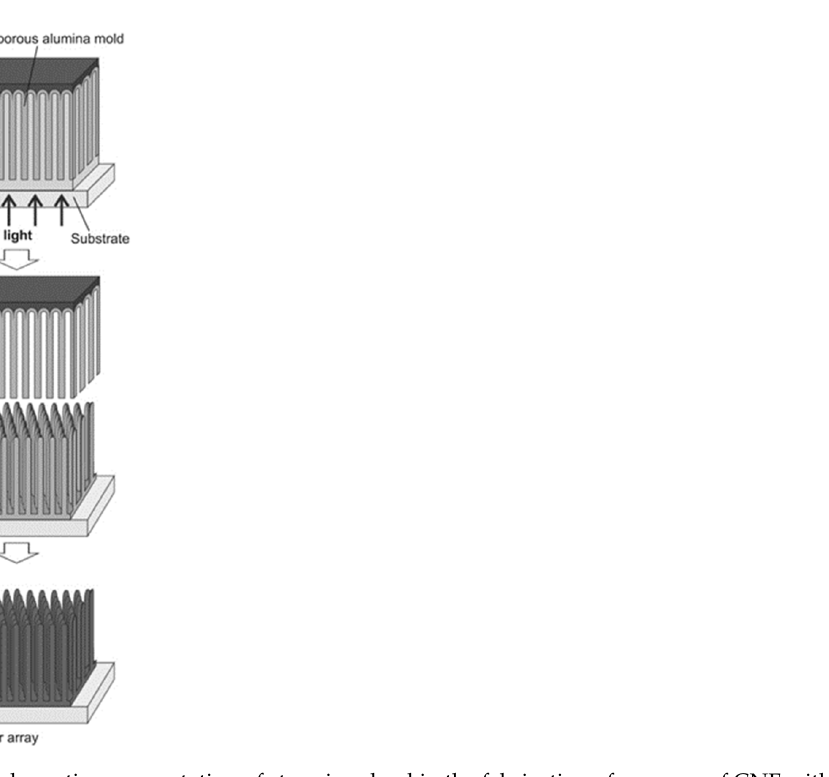
Figure 24. ( a ) Schematic representation of steps involved in the fabrication of an array of CNF with a high aspect ratio by nanoimprinting using PAA as a mold: ( a ) nanoimprinting, ( b ) detaching the mold, and ( c ) carbonization of a polymer by heat treatment under vacuum. Reprinted with permis-